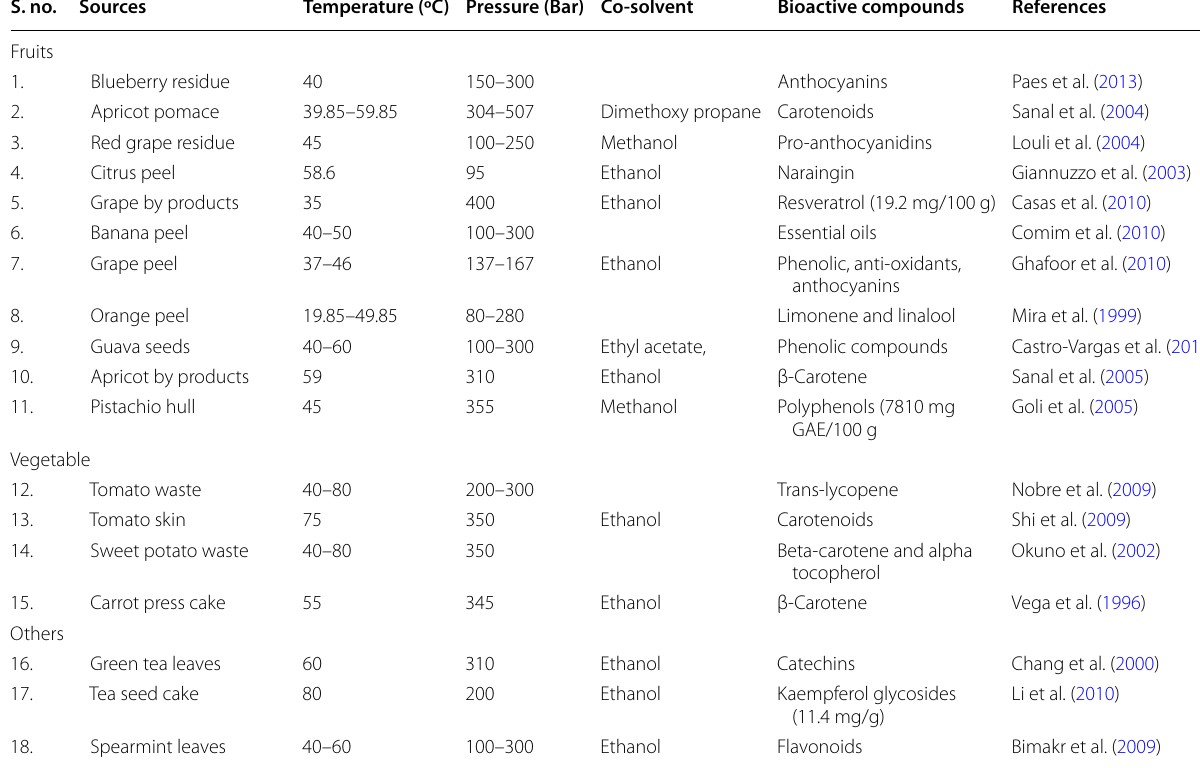
Table 2 Extraction, recovery and characterization of bioactive compounds using supercritical fluid extraction S. no.